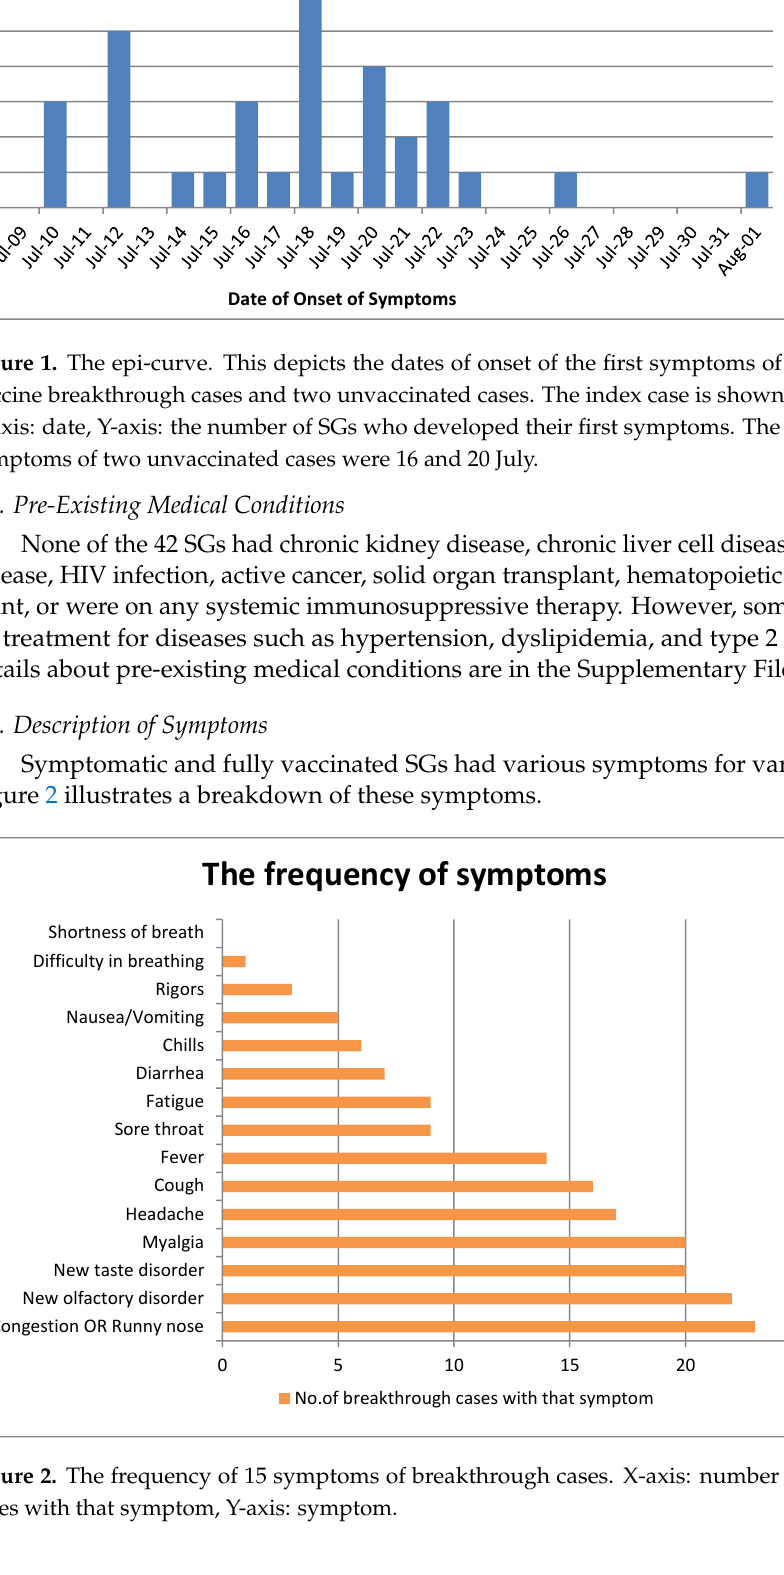
Table 1. Number of breakthrough cases; number of symptoms.